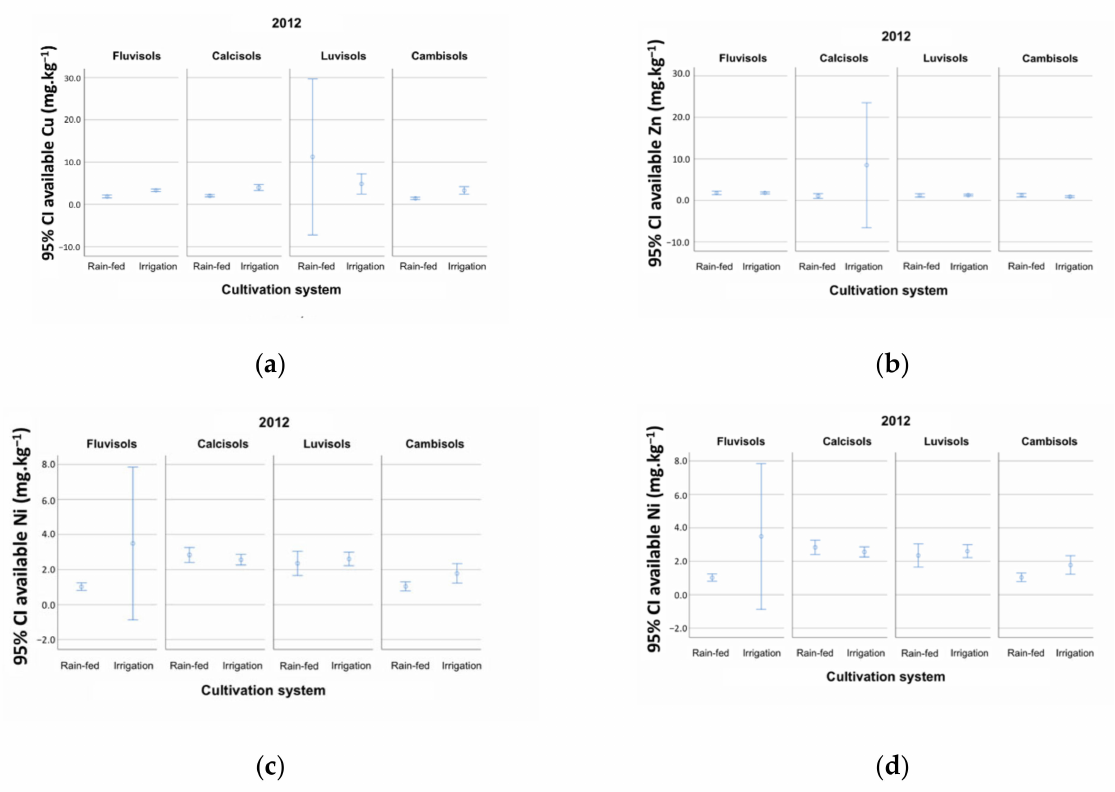
Figure 4. Error bars for the sample year 2012 by RSG for the available ( a ) Cu, ( b ) Zn, ( c ) Mn, and ( d ) Ni.